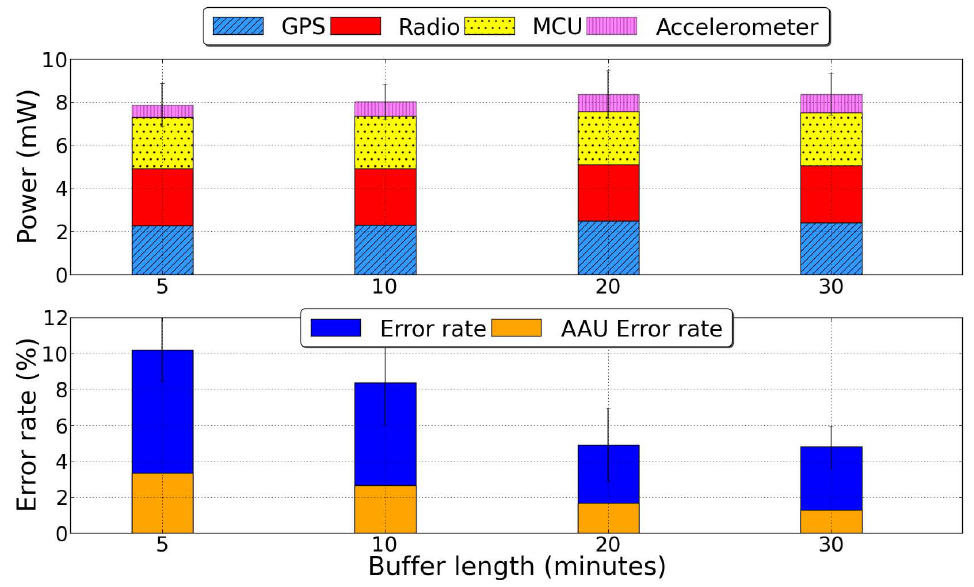
Figure 19. Performance with different sizes of neighbour history buffer. A longer buffer size of 30 minutes helps establish stable groups.